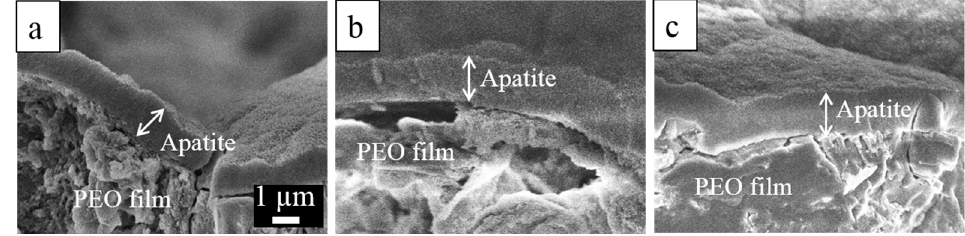
Figure 12. Cross-sectional SEM images of the apatite layer formed on the anodized surfaces of ( a ) AM60; ( b ) AM60-1Ca; and ( c ) AM60-2Ca after incubation in SBF for 14